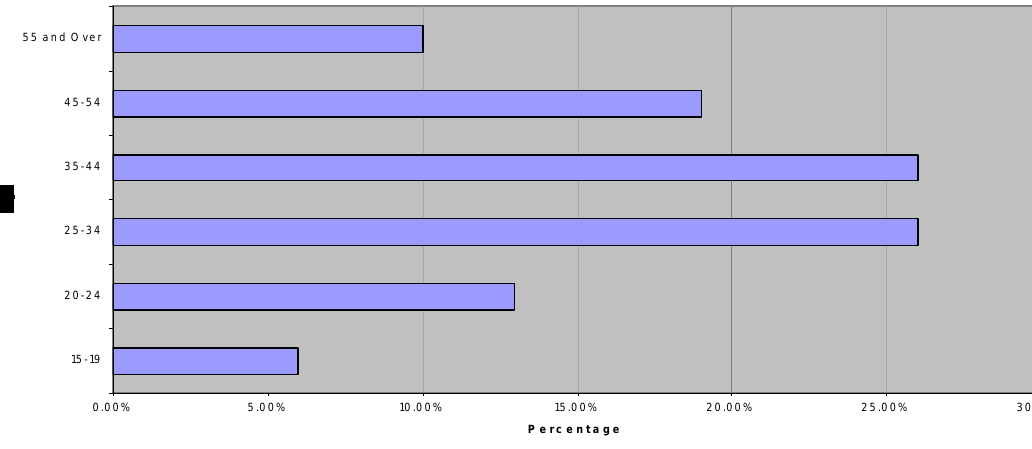
Table 1 Employed Persons in the Construction industry as a